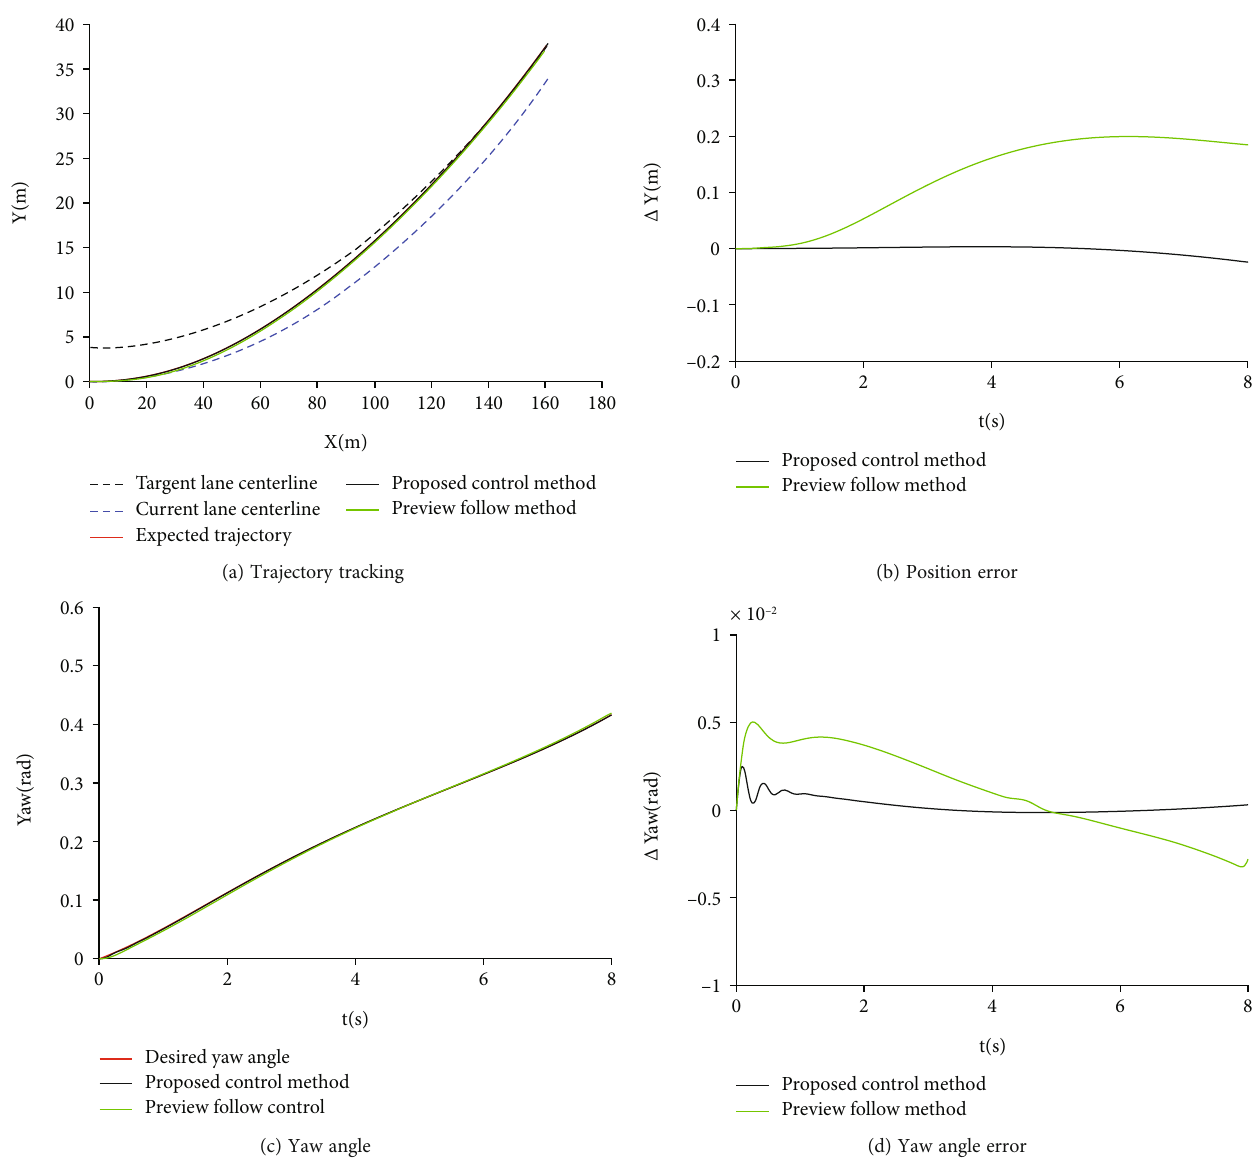
Figure 3: Comparison of trajectory tracking control e ff